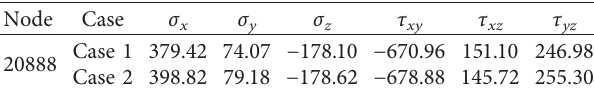
Table 5: Stress components at the critical point (unit: